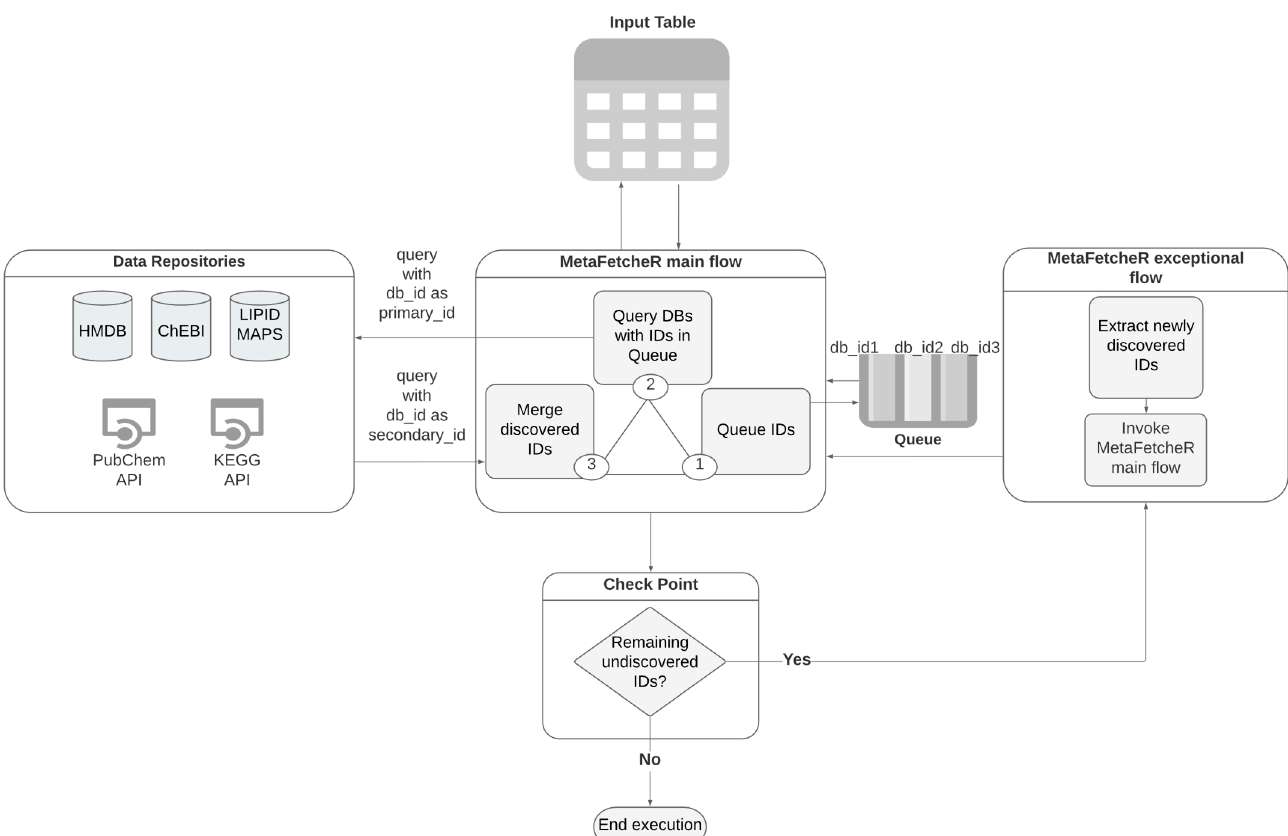
Figure 1. A simplified graphic illustration of the MetaFetcheR algorithm. Data repositories represent the local database built during installation of the package and the http calls to the application programming interfaces (APIs) for PubChem and KEGG. MetaFetcheR main flow represents the main flow of the algorithm, which constitutes three main steps. Queue represents the working queue data structure the algorithm utilizes to add all the primary and secondary known IDs from the input table and consequently preform the search queries with the IDs present in the queue. Check point is the step when the algorithm has emptied the queue after a round of search to check if the input table still has empty fields, in which case, it utilizes the steps in MetaFetcheR exceptional flow. A detailed version is available in Supplementary Materials Figure S2.